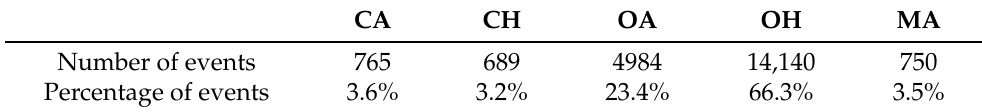
Table 3. Total number of sleep disordered breathing events, per category, in the database. CA CH OA OH MA Number of events 765 689 4984 14,140 750 Percentage of events 3.6% 3.2% 23.4% 66.3%